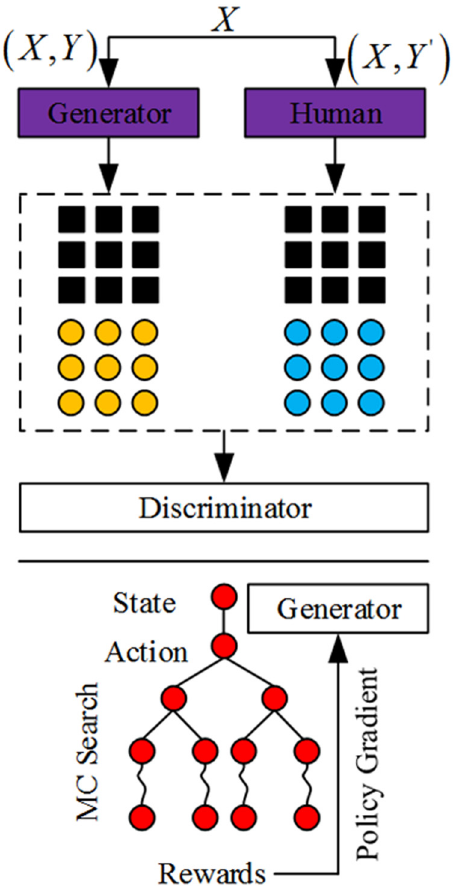
Figure 3: General learning framework of confrontation network